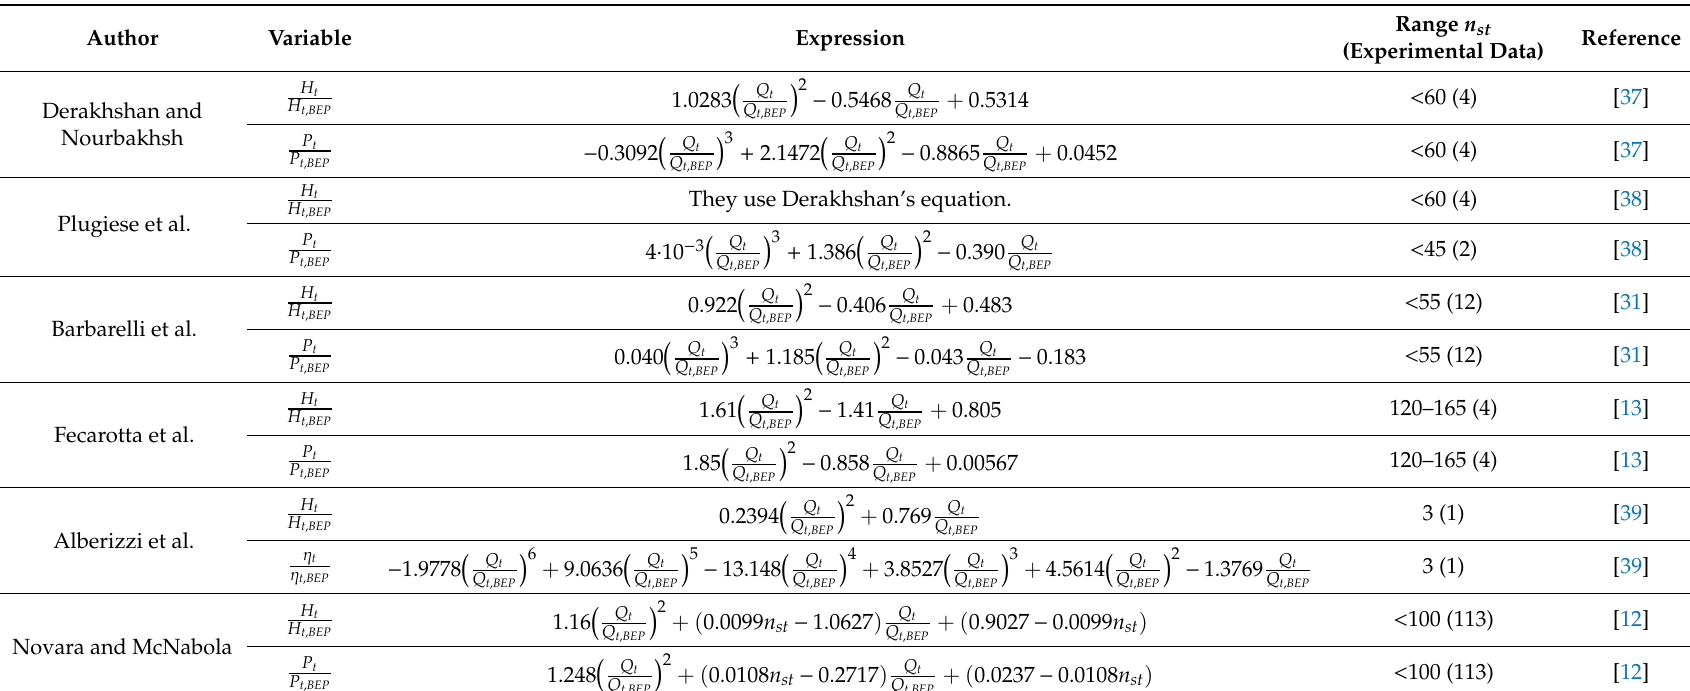
and P t as a function of Q t H t , BEP P t , BEP Q t , BEP